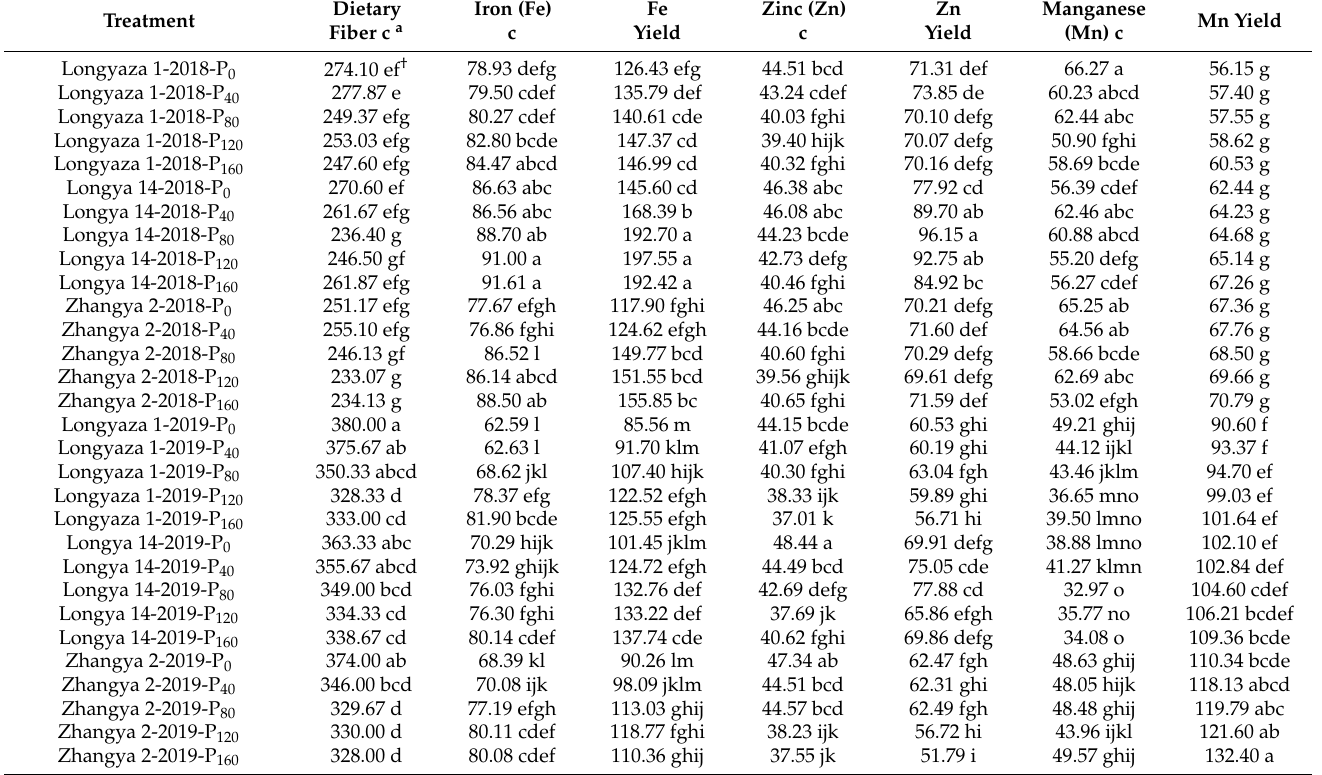
Table 4. Interaction of year, phosphorus levels, and cultivar relating to dietary fiber concentration, and concentrations and yields of Fe, Zn, and